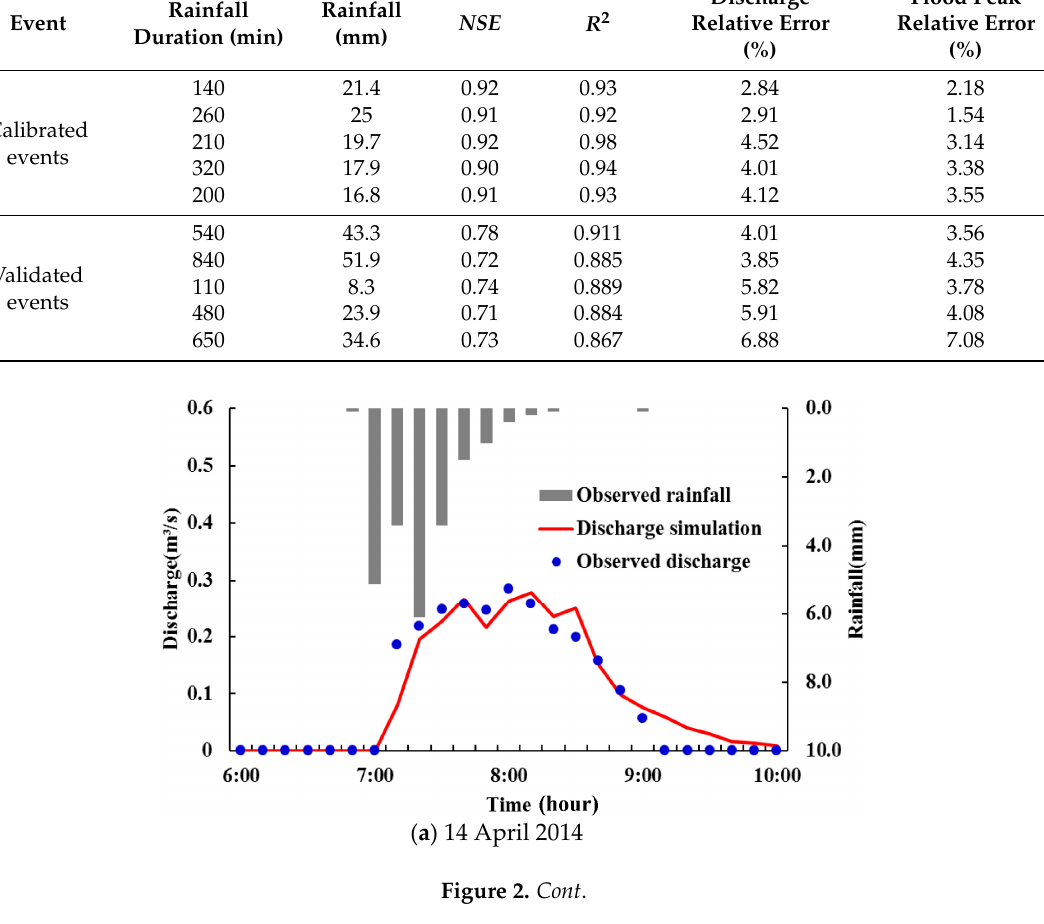
Table 4. Calibration and validation results of the rainfall–runoff